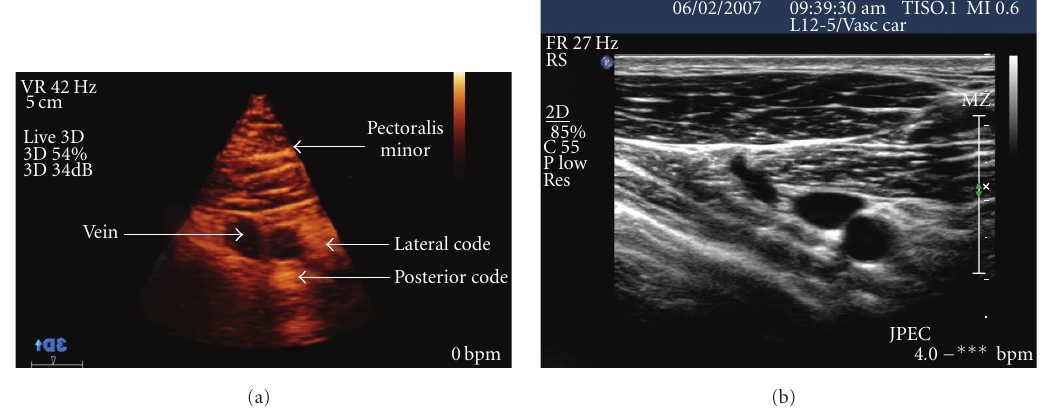
Figure 3: (a) Three-dimensional infraclavicular ultrasound image. (b) Two-dimensional infraclavicular ultrasound